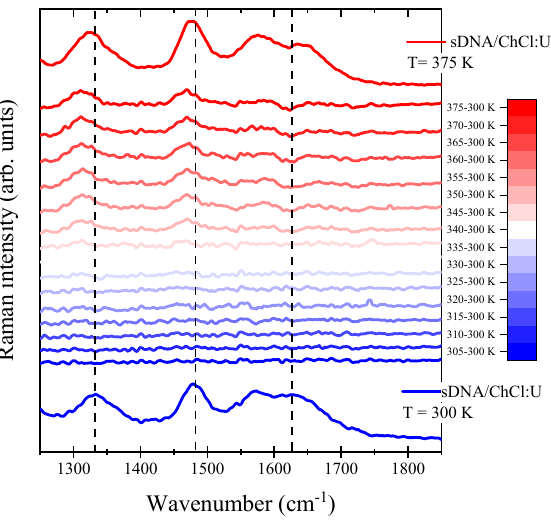
Figure 2. 250 nm-excited Raman spectra of sDNA/ChCl:U (1:158) collected at 300 K (bottom trace) and 375 K (top trace). Intermediate traces show the difference spectra computed by subtracting the spectrum measured at the lowest temperature, 300 K, from the spectrum at the indicated higher temperatures.